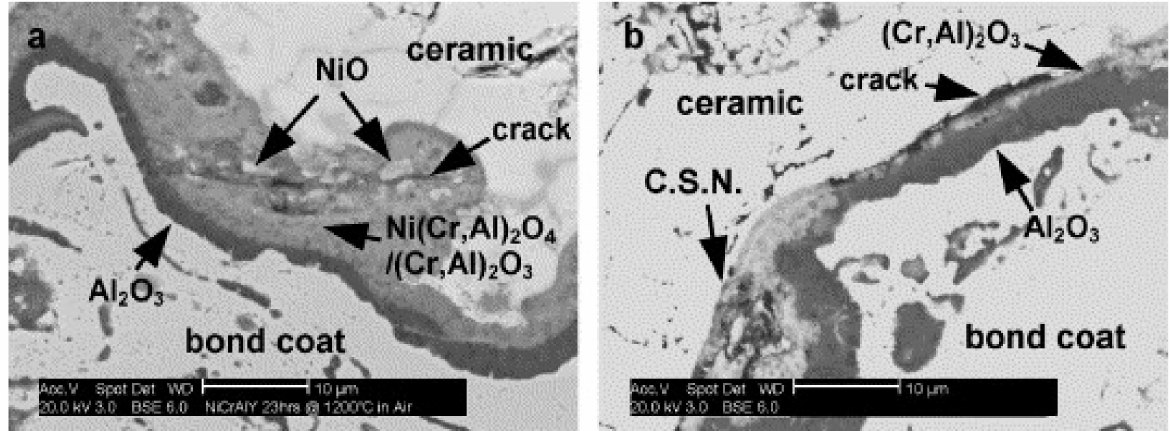
Figure 6. SEM images of crack nucleation via void formation in (Cr,Al) 2 O 3 · Ni(Cr,Al) 2 O 4 · NiO ( a ), and at the interface between ceramic topcoat and (Cr,Al) 2 O 3 ( b ) after 23 h in air at 1200 ◦ C